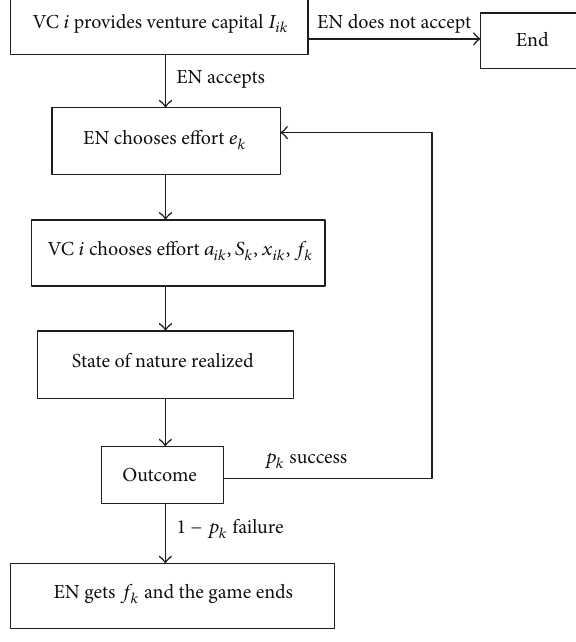
Figure 2: The time